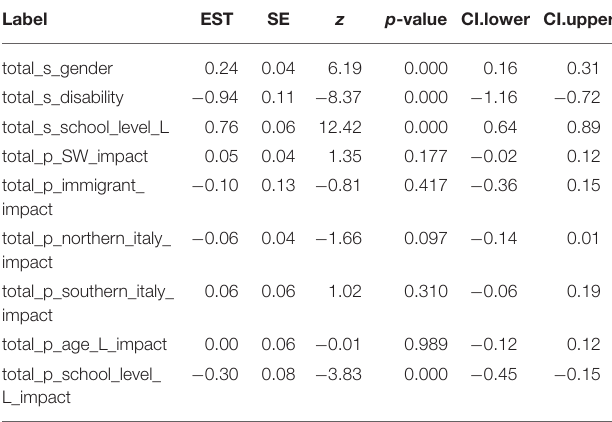
TABLE 6 | Estimates of total effects on